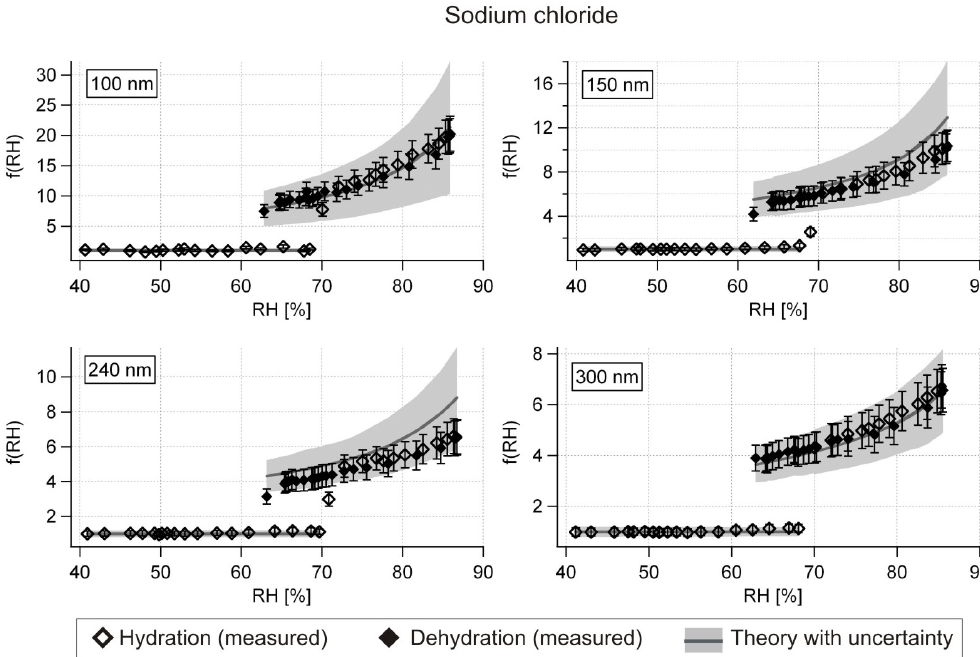
Fig. A4. f (RH) vs. RH of sodium chloride particles with a diameter of 100, 150, 240, and 300nm. The grey lines represent the predicted f (RH) with corresponding uncertainties. Black open diamonds show the measured f (RH) of hydrating aerosols, while black closed diamonds represent dehydrating aerosols.